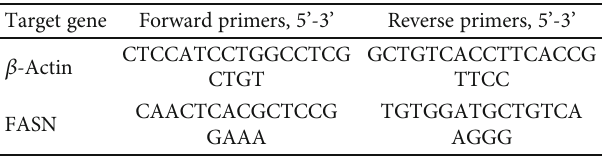
Table 1: quantitative reverse transcription-polymerase chain reaction (qRT-PCR)